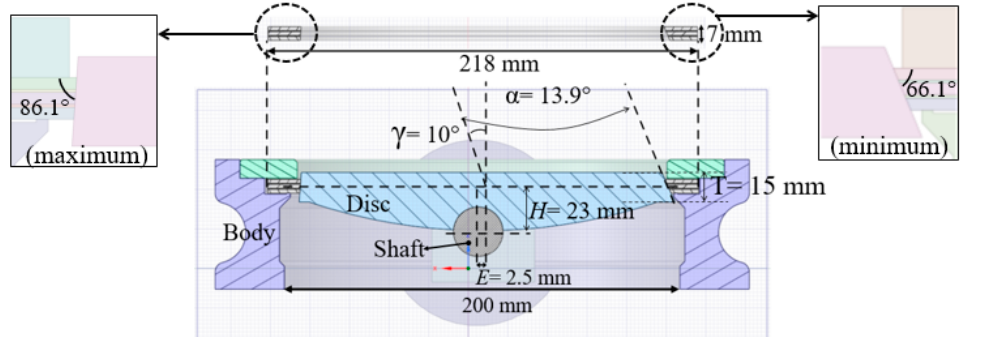
Figure 10. Two-dimensional (2D) geometry of triple offset butterfly valve (TOBV).